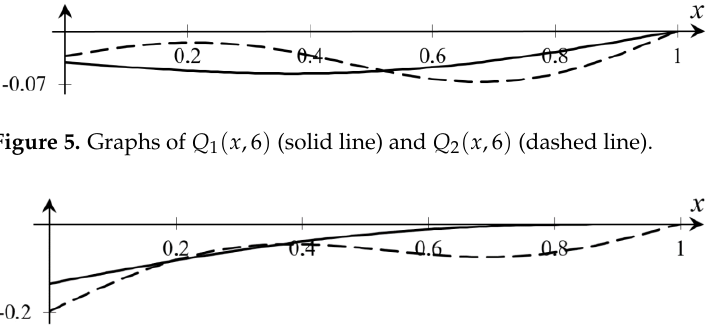
Figure 4. Graphs of 𝑄 1 (𝑥, 3) (solid line), 𝑄 2 (𝑥, 3) (dashed line) and 𝜑 1 (𝑥) (dash-dotted line).